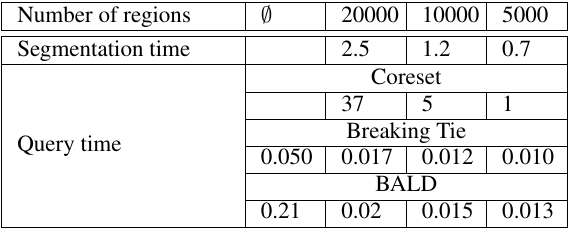
Table 2. Approximate time requirements in minutes with our hardware 1